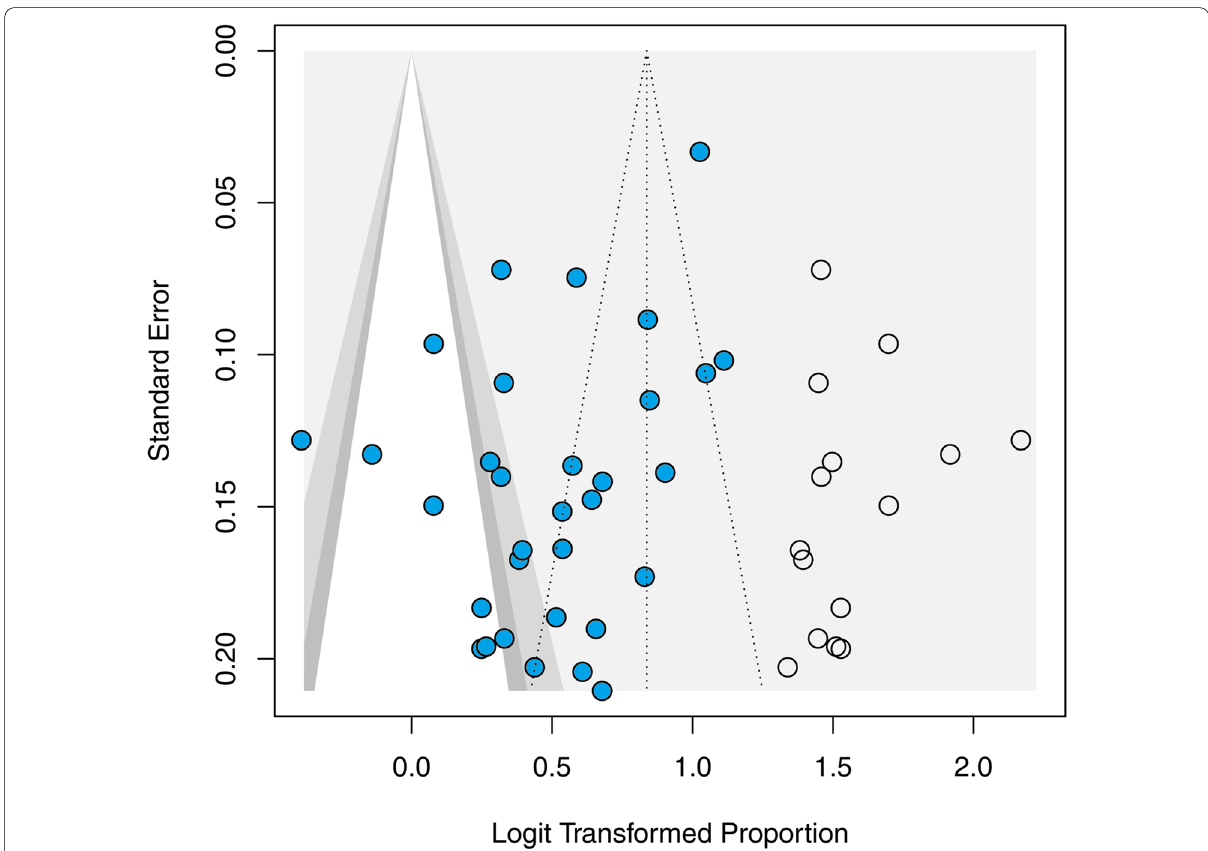
Fig. 2 Funnel plot with the trim-and-fill method. Solid circles present the analysis of included studies. Open circles indicate missing studies imputed by the trim-and-fill